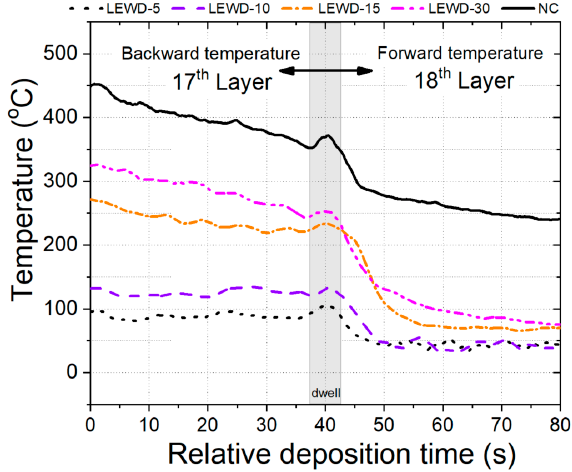
Figure 8. Temperature data from the trailing/leading IR pyrometer (after the deposition of 2 layers) of the 350 mm-long walls.